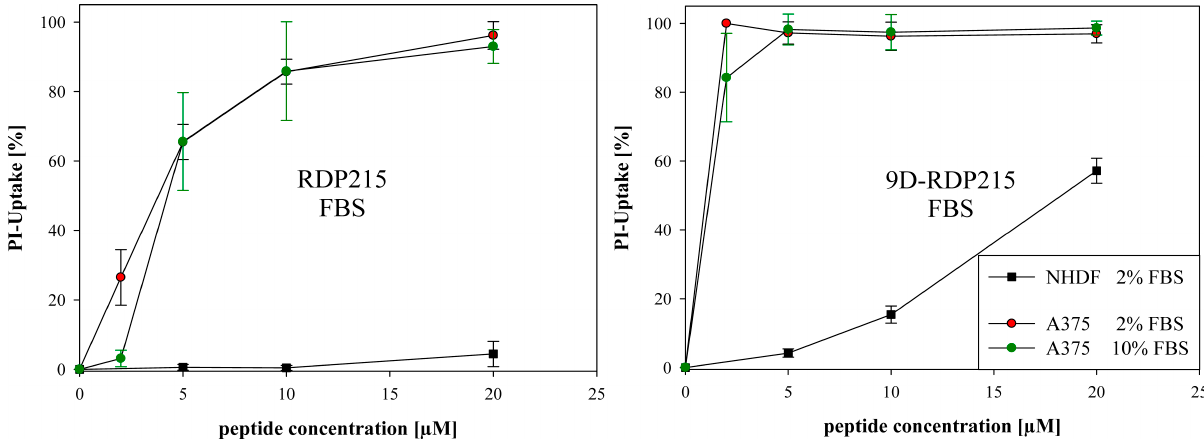
Figure 9. Specific toxicity of RDP215 and 9D-RDP215 on the malignant melanoma cell line A375 and normal human dermal fibroblasts in the presence of 2% and 10% fetal bovine serum (FBS). Cell death (%) was determined by PI-uptake in presence of 2 µM, 5 µM, 10 µM and 20 µM peptide concentration upon 8 h of incubation in the presence of 2% (red circles) and 10% FBS (green circles), respectively. For the determination of cancer specificity, cytotoxicity on normal human dermal fibroblasts NHDF (2% FBS) (black squares) was studied. Both peptides show high activity and specificity for melanoma cells, mainly independent of the concentration of FBS. At lower molar concentration (2–5 µM), the D-peptide exhibits increased stability and significantly increased antitumor activity; however, at higher molar concentrations, cytotoxicity also increases. Data represent mean values of at least 4 independent experiments with standard deviation given.